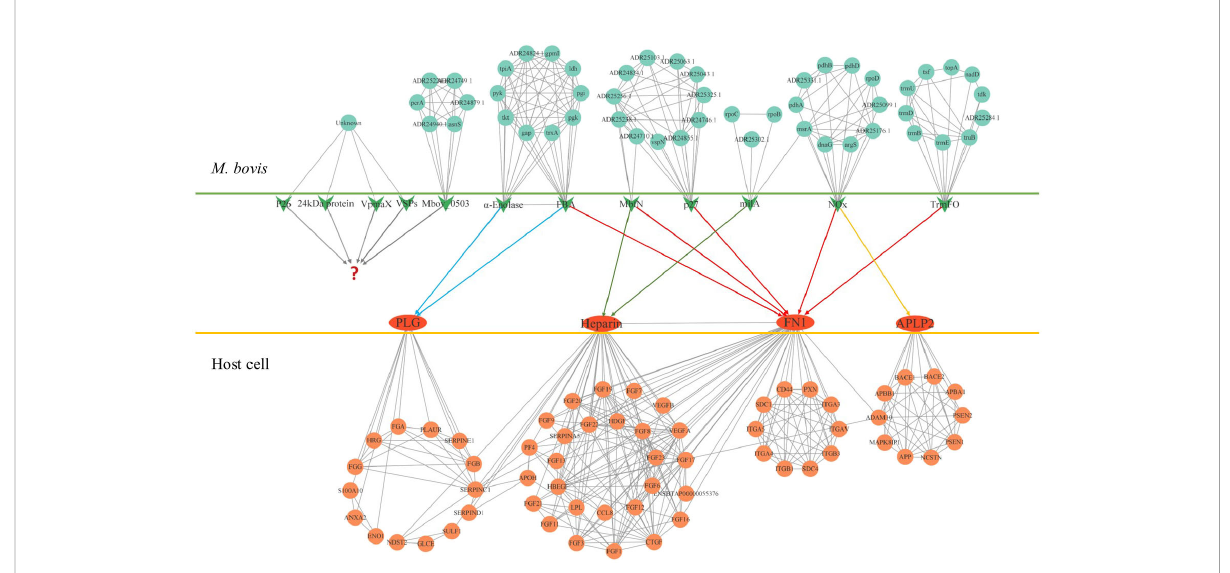
FIGURE 1 The protein interaction network of M. bovis adhesin and adhesin-binding protein. The green arrows in the fi gure represent adhesins, and the red ovals represent adhesin-binding proteins. Cyan circles represent proteins that interact with adhesin in M. bovis , light red circles represent proteins that interact with adhesin-binding proteins of the host, and question marks represent unidenti fi ed adhesin-binding proteins. The relationship of the adhesin to the corresponding binding protein is indicated by the line segment with the